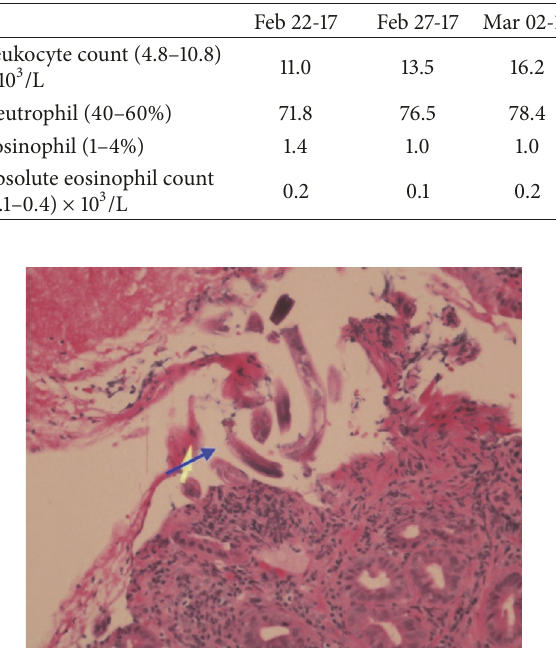
Figure 1: Haematoxylin and eosin (H&E) stain, gastric mucosa nonfundic type, pointing to fragments of Strongyloides stercoralis under 200x (blue arrow).